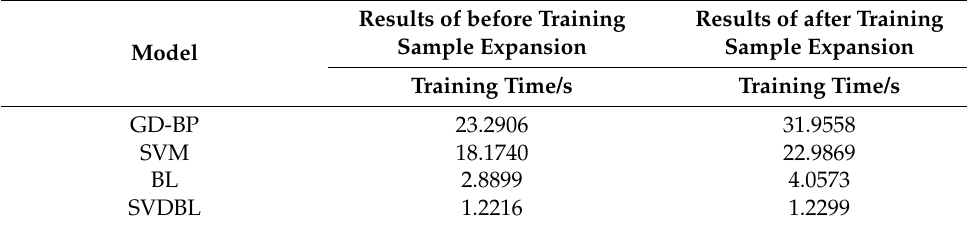
Table 9. Comparison of results before and after training sample expansion.